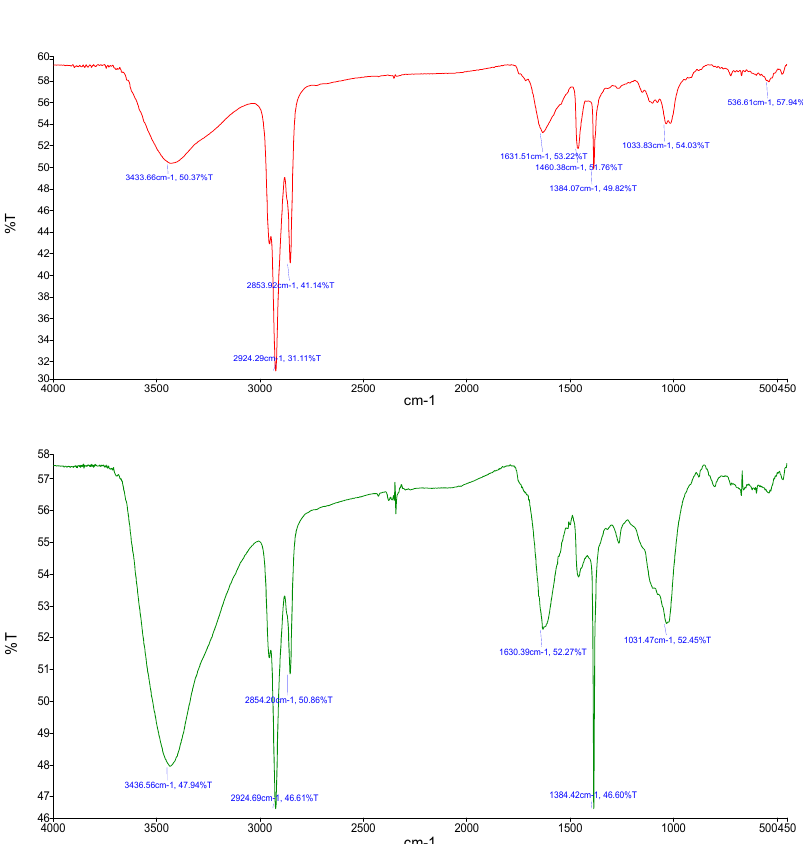
Figure A1. FTIR spectra of C. roseus (upper panel) and A. indica (lower panel) silver nanoparticles.